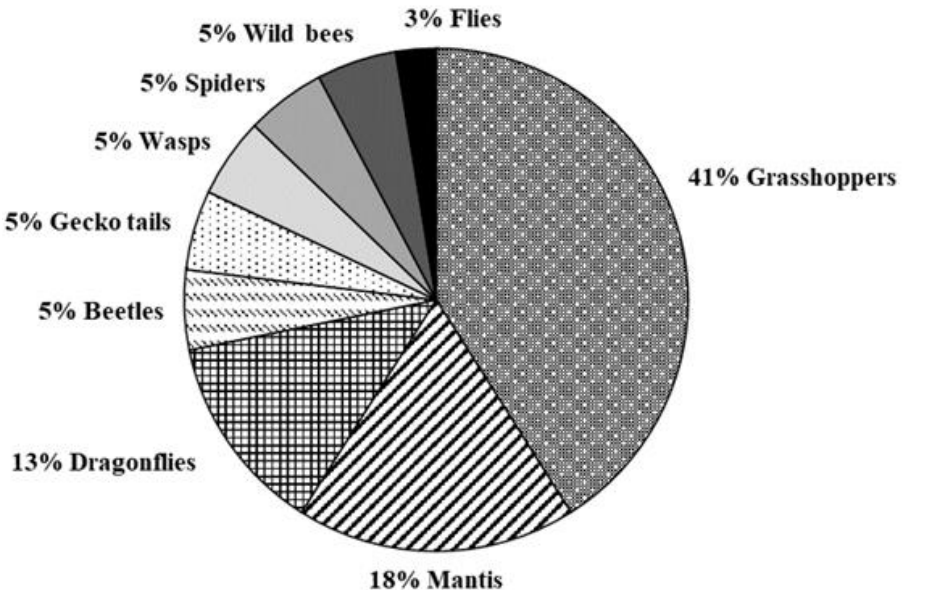
Figure 6. Relative frequency of the type of prey observed between the jaws of European hornet workers returning to the nest.